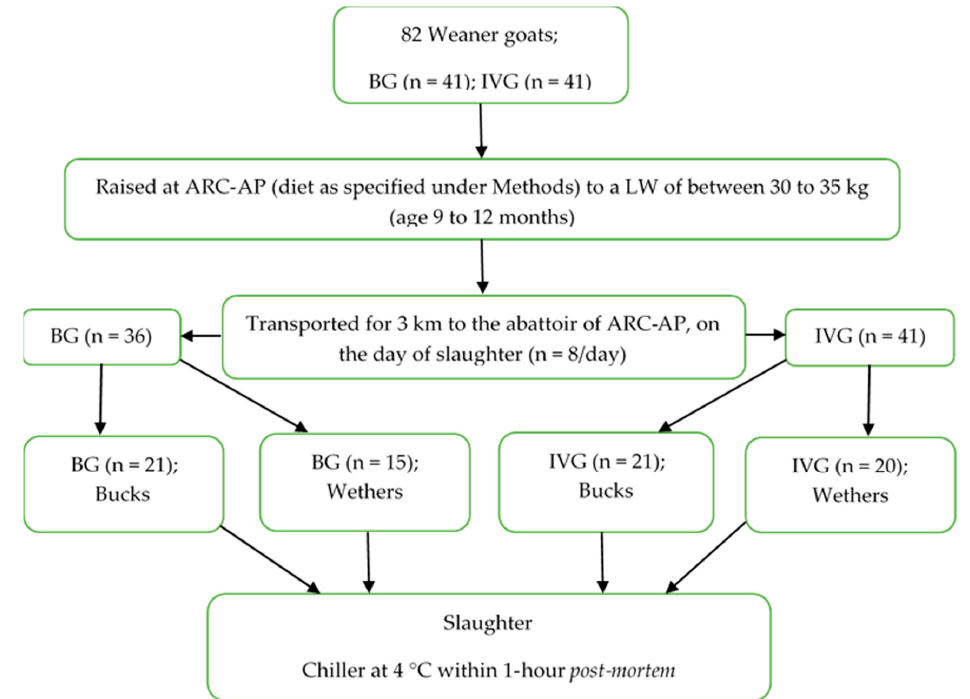
Figure 1. Experimental design to determine yield of Boer Goats (BG) and large frame Indigenous